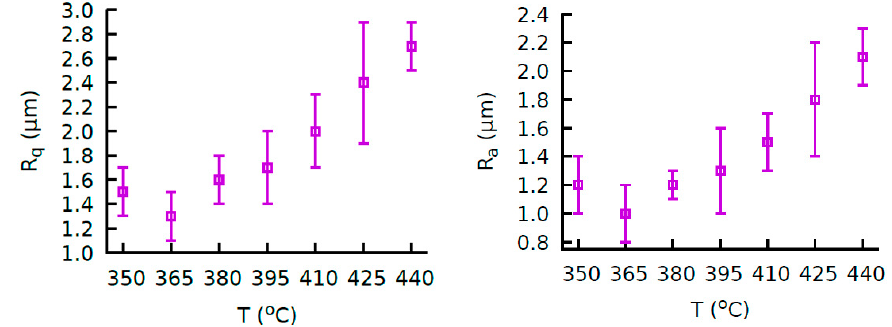
Figure 1. Root-mean square and arithmetic roughness of the fluoropolymer coatings cured at different temperatures. Above the melting point, the roughness amplitude increases as the temperature.